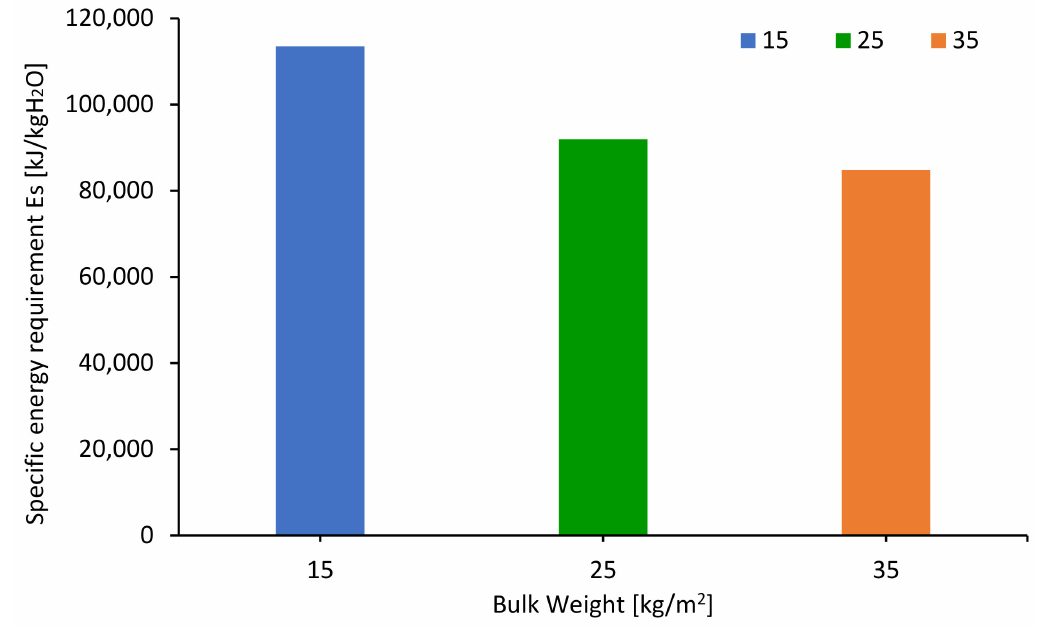
Figure 15. Specific energy requirement for three di ff erent hop bulks dried at 60 ◦ C and 0.35 m /